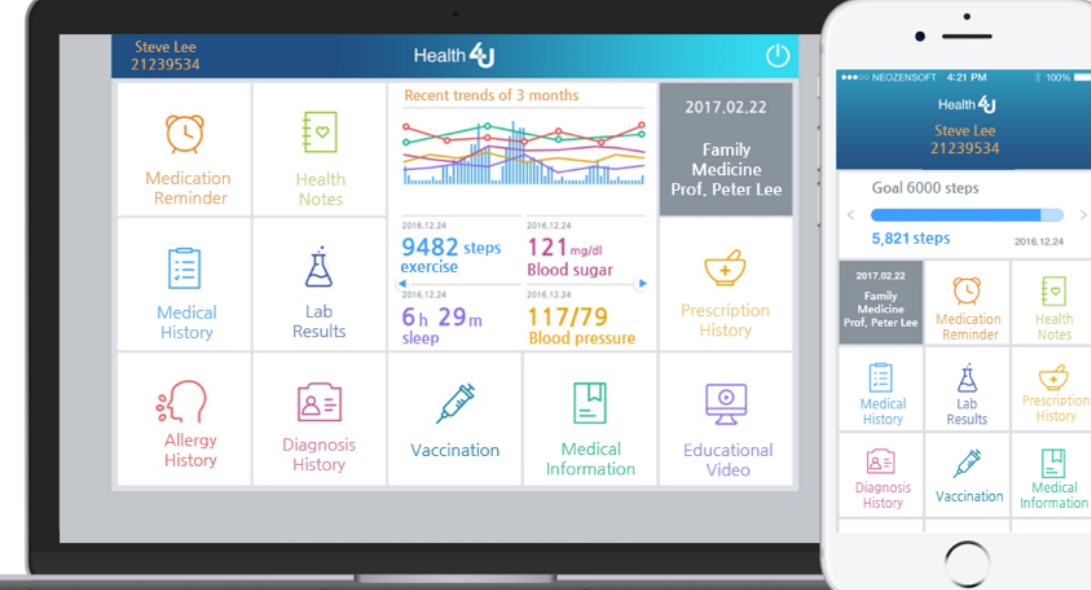
Figure 3. Screenshots of Lifelog